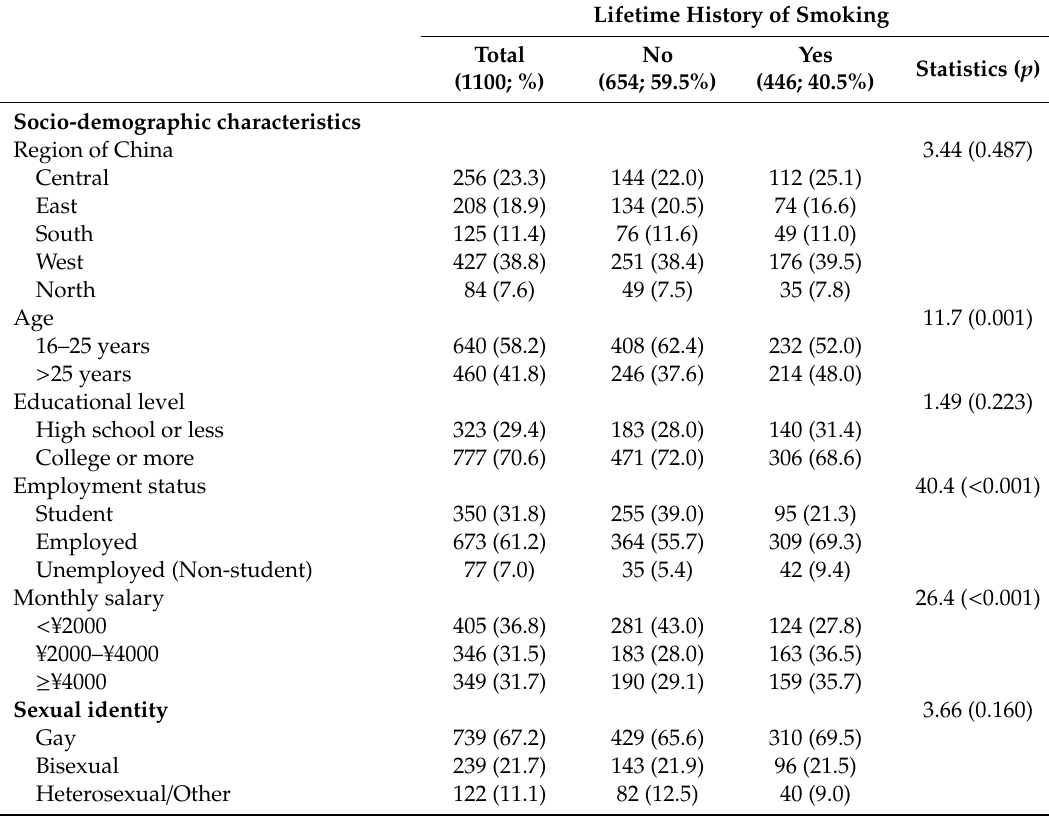
Table 1. Participant socio-demographic characteristics and sexual identity by lifetime history of smoking among a national sample of Chinese men who have sex with men